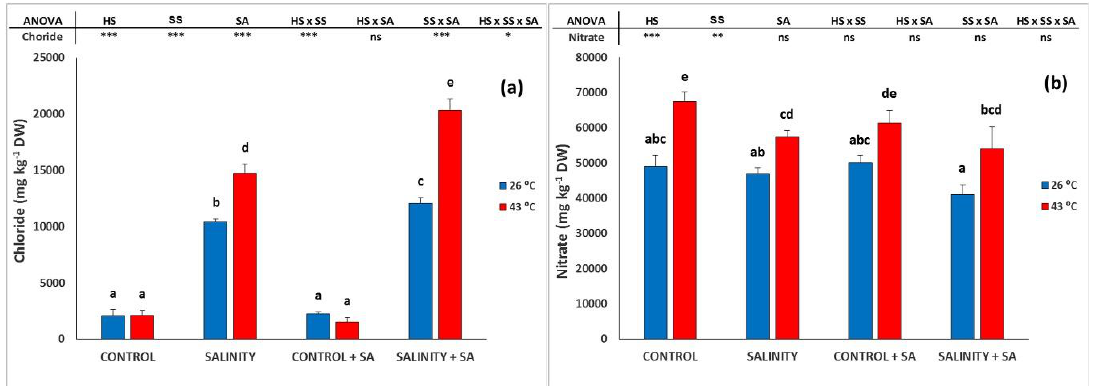
Figure 2. Effect of heat-shock and salinity, with or without salicylic acid, on the Cl − ( a ) and NO 3 − ( b ) concentrations in the leaves of pepper plants. The * refers to significant differences at the level of p ≤ 0.05; ** p ≤ 0.005; *** p ≤ 0.001; n.s. , not significant. Different lowercase letters denote significant differences between columns, p < 0.05 HS is heat stress; SS is salinity stress; SA is salicylic acid.